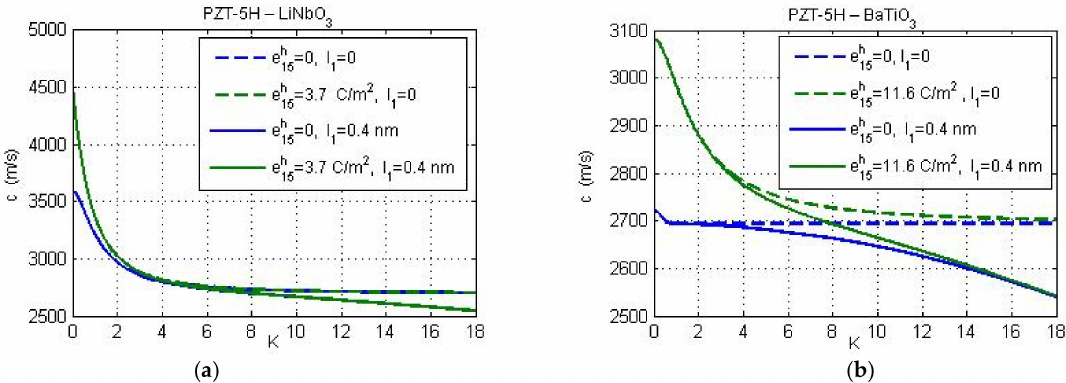
Figure 4. Influence of the piezoelectricity on the phase velocity c for two substrate materials: ( a ) LiNbO 3 , and ( b ) BaTiO 3